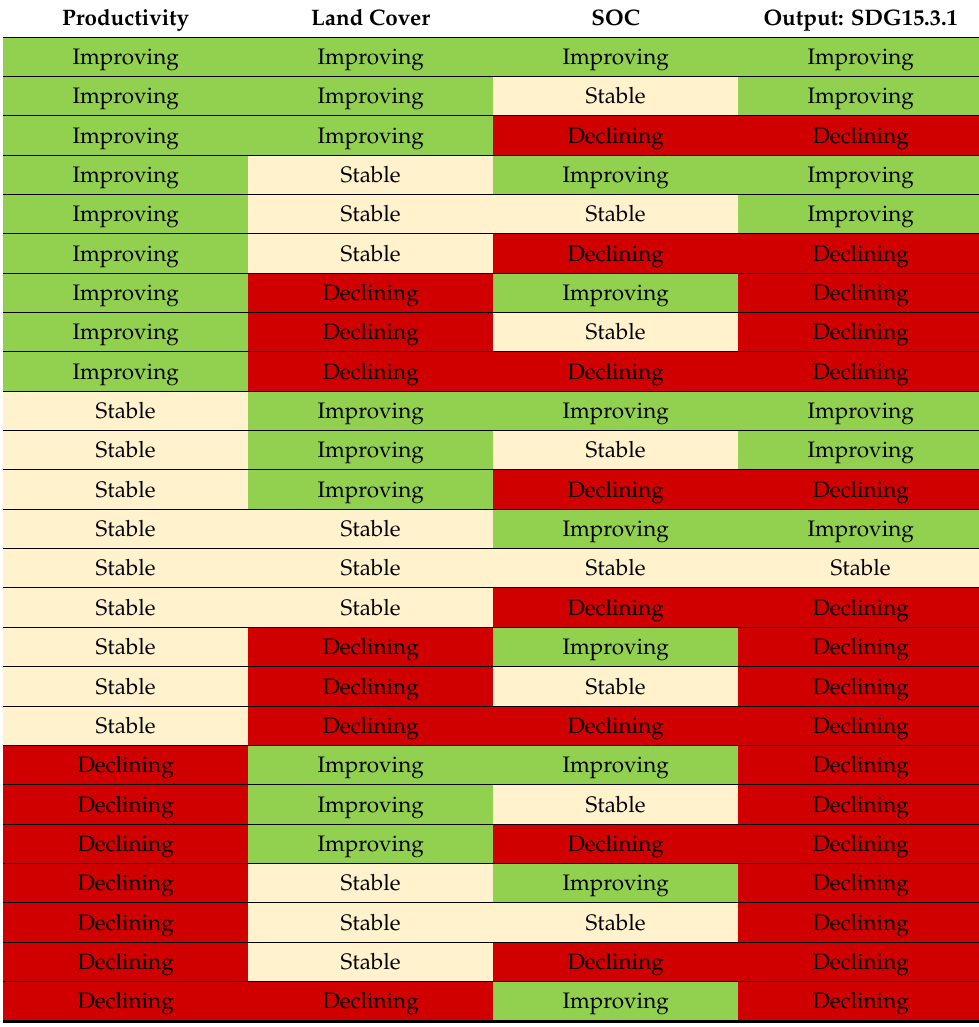
Table 1. The relations used for the spatial characterization of SDG15.3.1. Productivity Land Cover SOC Output: SDG15.3.1 Improving Improving Improving Improving Improving Improving Stable Improving Improving Improving Declining Declining Improving Stable Improving Improving Improving Stable Stable Improving Improving Stable Declining Declining Improving Declining Improving Declining Improving Declining Stable Declining Improving Declining Declining Declining Stable Improving Improving Improving Stable Improving Stable Improving Improving Declining Stable Improving